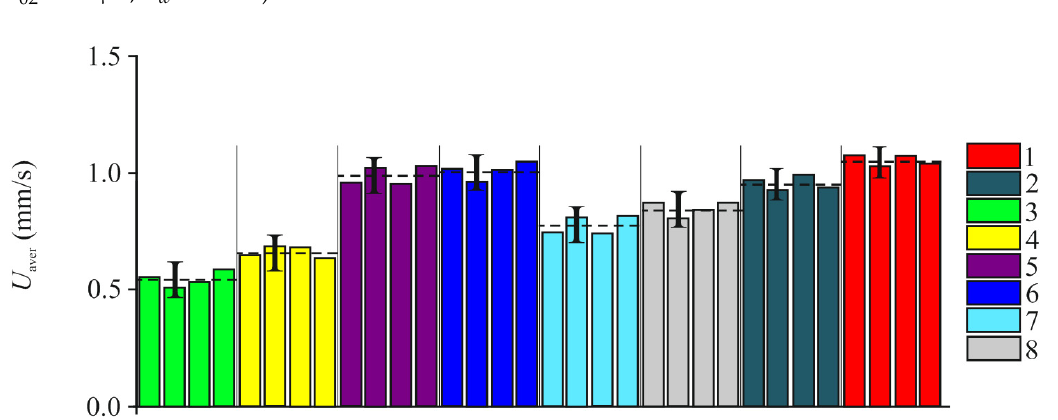
Figure 14. Velocity U aver in the horizontal section of sessile drop 2 ( V 02 = 40 µ L; T w = 80 ◦ C); (1 and 2)—without the fall of small droplet 1; (3–8)—in 3 s after the fall of small droplet 1 with temperature of 20 ◦ C (sessile drop 2 consists of water). Composition of drops: 1—sessile drop 2 (water); 2—sessile drop 2 (water with graphite particles); 3—droplet 1 (surfactant AF 9-12 (4%), V 01 = 5 µ L); 4—droplet 1 (surfactant AF 9-12 (4%), V 01 = 2.5 µ L); 5—droplet 1 (surfactant OP-10 (1%), V 01 = 2.5 µ L); 6—droplet 1 (surfactant OP-10 (1%), V 01 = 5 µ L); 7—droplet 1 (surfactant SDS (0.1%), V 01 = 5 µ L); 8—droplet 1 (surfactant SDS (0.1%), V 01 = 2.5 µ L); I is the interval of measurement errors and I is the interval of measurement errors relative to the dotted horizontal line (average velocity value over four repeated experiments).